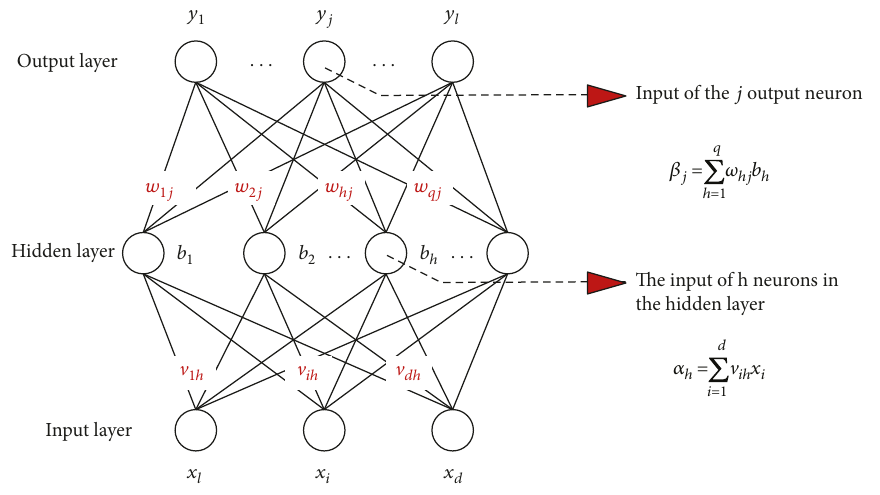
Figure 5: Structure diagram of the BP neural